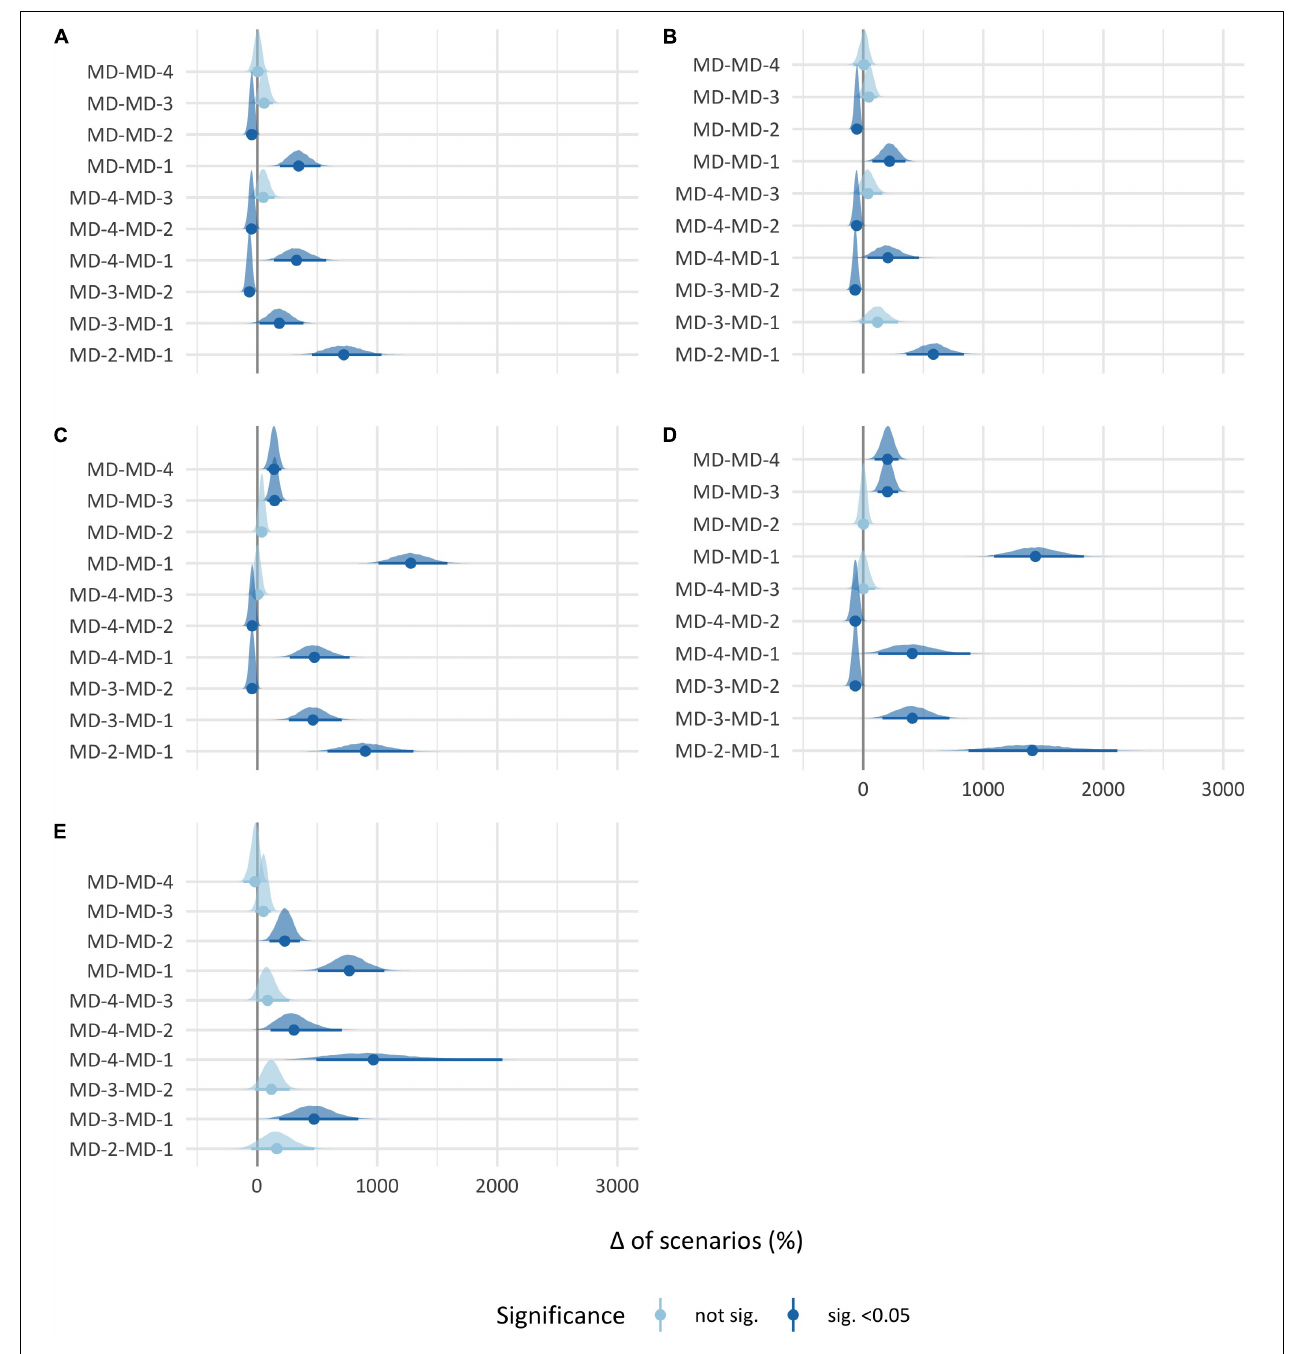
FIGURE 2 | 95% Confidence interval percentage change of very high-demanding scenarios between match days. Each point represents the mean percentage change, and each black line through the point represents the 95% confidence interval of the percentage change between the two match days. (A) Absolute high-speed running. (B) Relative high-speed running. (C) Total distance. (D) Player load. (E) High-intensity